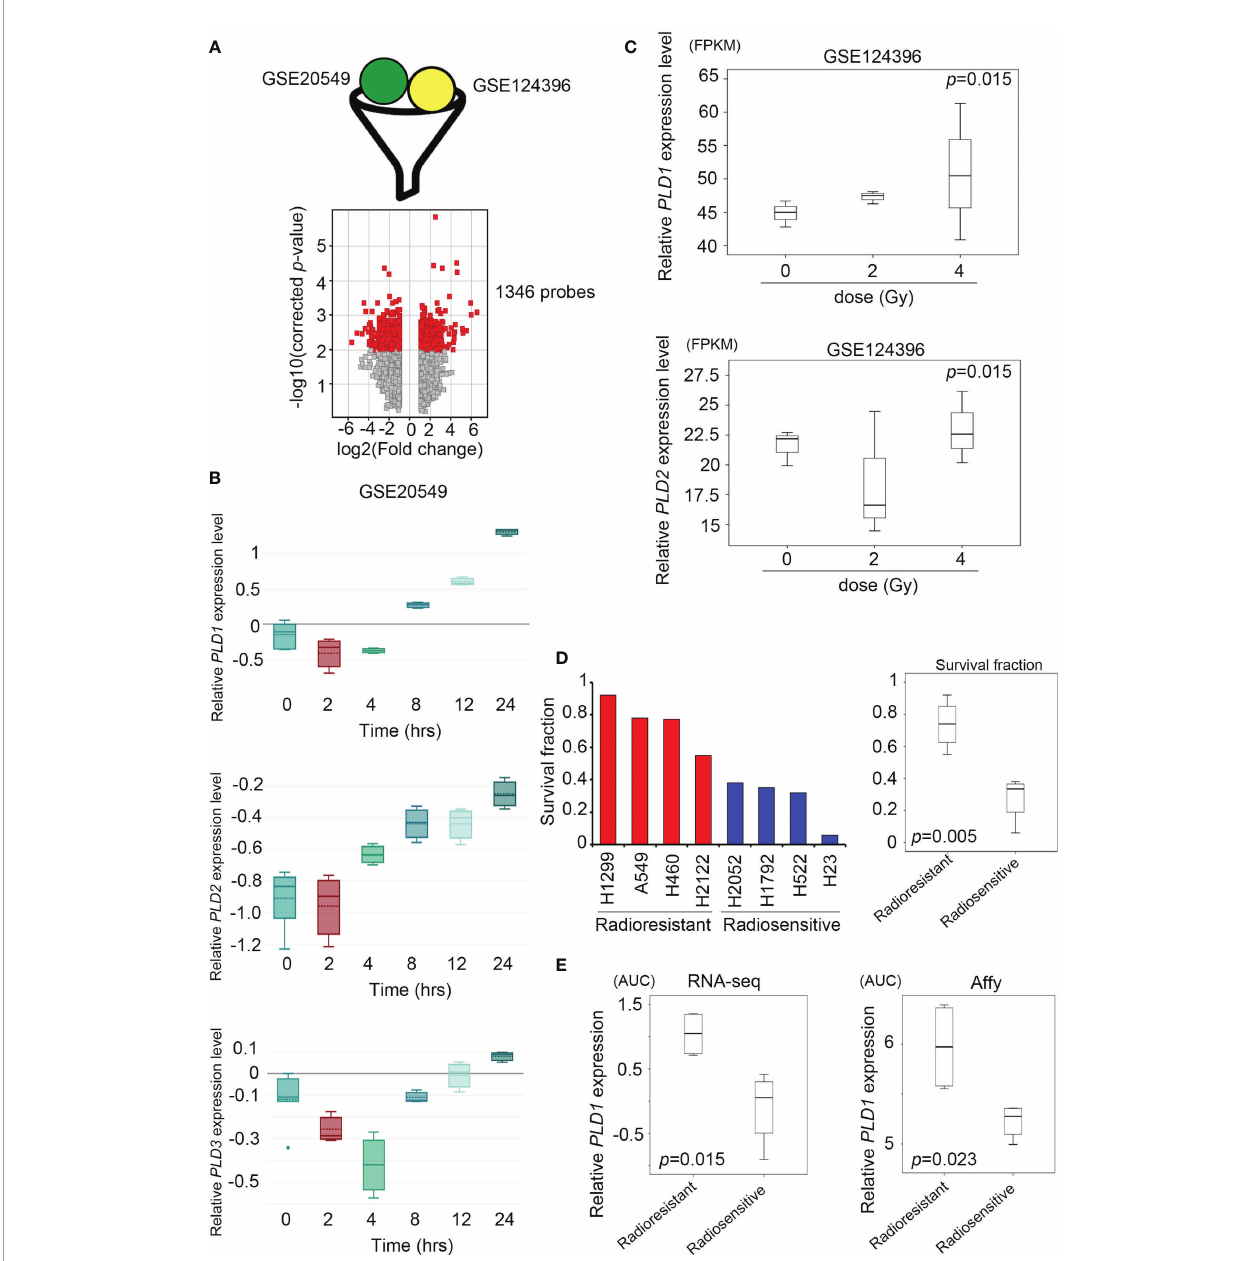
FIGURE 2 | | Lung cancer cells activate the expression of the phospholipase D family under radiation stimulation. (A) Combine the GSE20549 and GSE124396 datasets and fi lter suitable targets. These data are obtained after cut-off and normalization (upper); the volcano plot showed that 1346 probes have become targets in the two datasets and changed to > log2 fold-change (lower). (B) Quantify the expression levels of PLD1 (upper), PLD2 (middle), and PLD3 (lower) at each time point (0, 2, 4, 8, 12, and 24 hours) after radiation exposure in the GSE20549 pro fi le. (C) Quantify the expression levels of PLD1 and PLD2 at each time point (0, 2, and 4 hours) after radiation exposure in the GSE124396 pro fi le. (D) Quantify the survival fraction of various lung cancer cells, and quantify the average of the radioresistant and radiosensitive groups. (E) Quantify the expression level of PLD1 in the radioresistant and radiosensitive group (left) microarray probes and (right) RNA-sequencing system. The signi fi cance of the difference was analyzed using the nonparametric Mann – Whitney U test. *p <